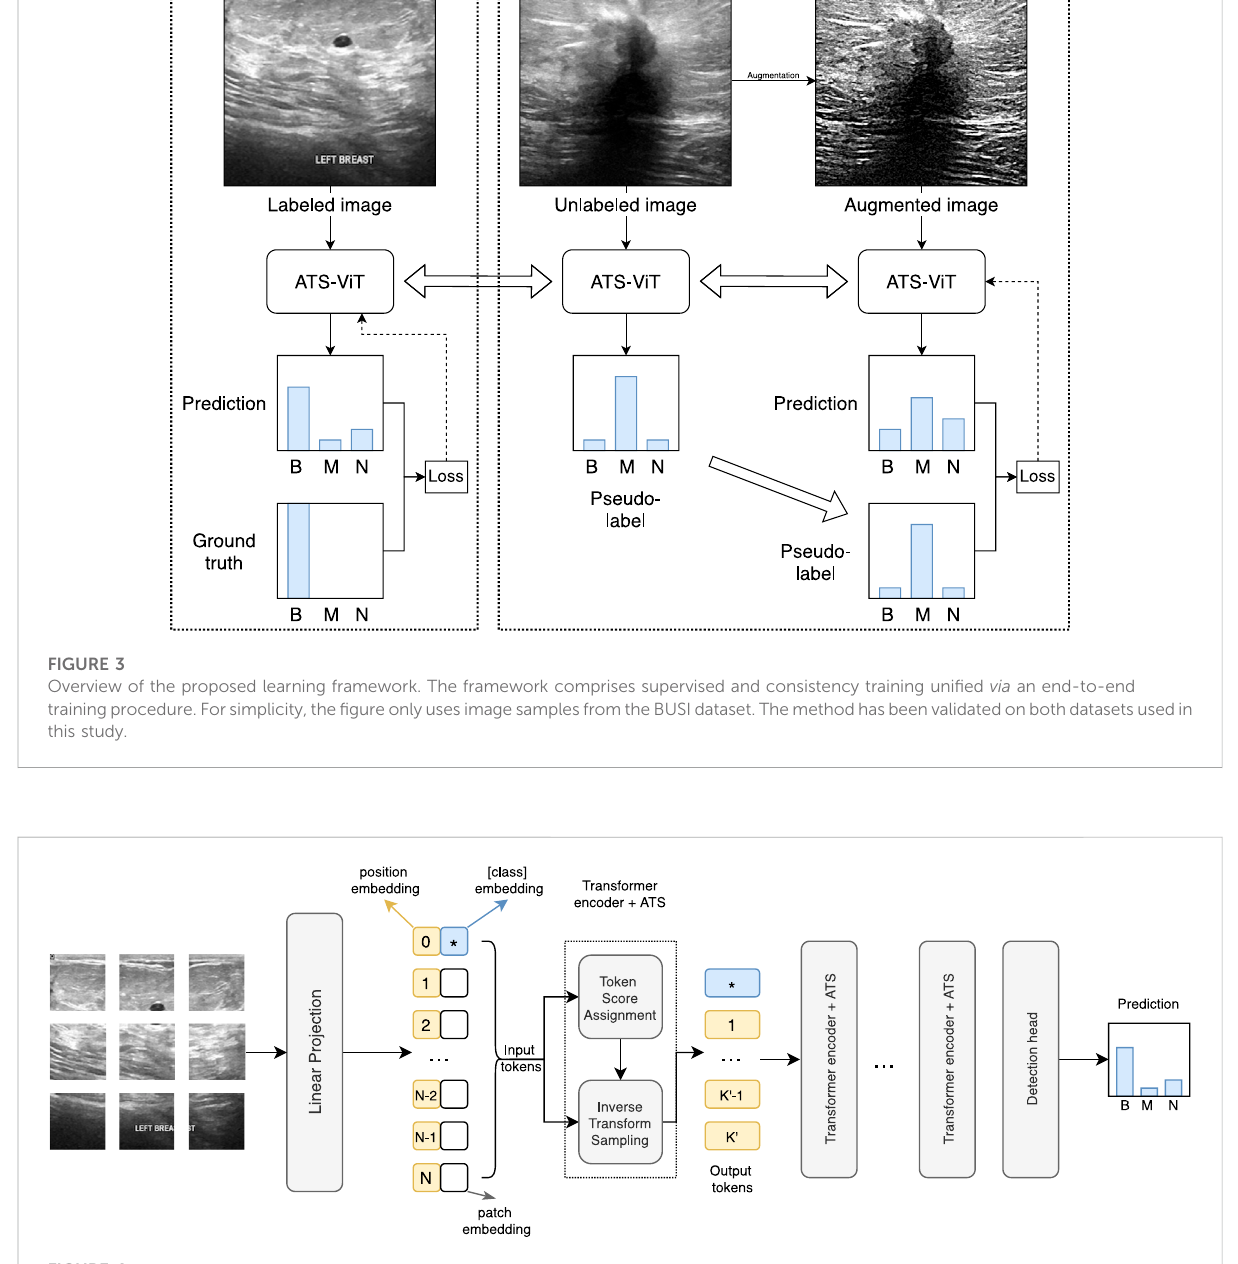
FIGURE 4 Architecture of the ATS-ViT. The ATS module can be integrated into each transformer block to perform two steps, including token score assignment and inverse transform sampling. The ATS can identify the most informative tokens that are passed to the subsequent layers, effectively reducing the computational cost and improving the classi fi cation